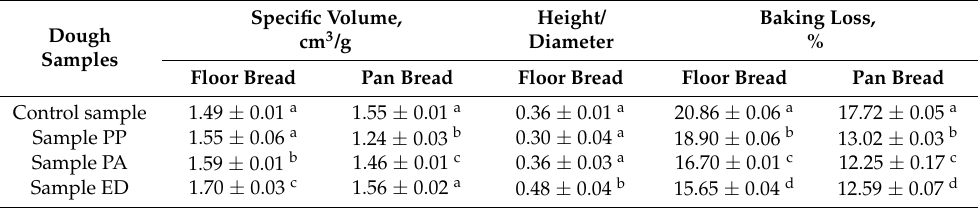
Table 8. Baking characteristics of nongluten breads with sourdough. Dough